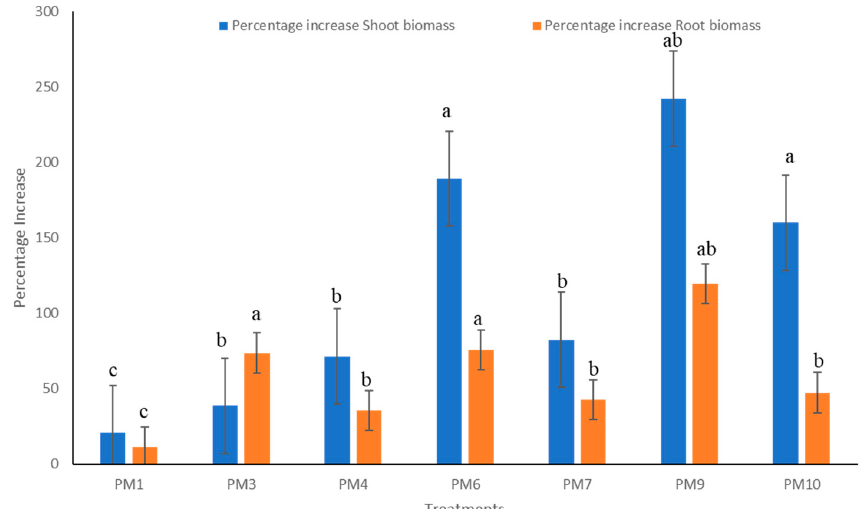
Figure 3. Impact of PGPR’s consortium on shoot and root biomass under field conditions. Different letters mean significant differences among categories ( p < 0.05). Error bars indicate ± SD. PM1—Control,